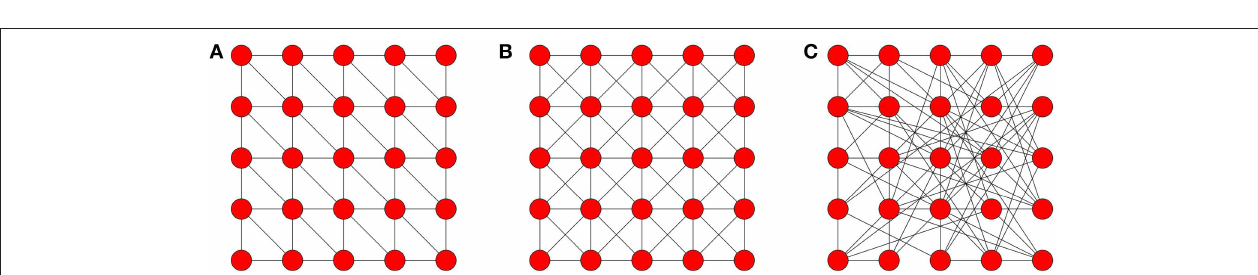
FIGURE 10 | Network topologies. Note that Centola used networks of sizes 98 , 128 , and 144 . These networks are wrapped around a torus to maintain the degree of each node. (A) hexagonal neighborhood; (B) Moore lattice; (C) random graph.